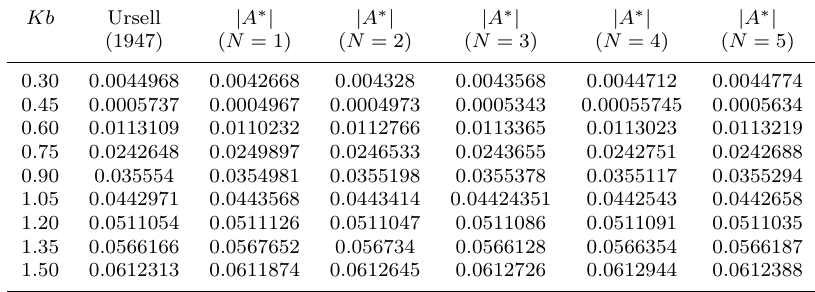
Table 1. Values of | A ∗ | against Kb for different values of N for a partially immersed plate with c/b = 0 . 4 .